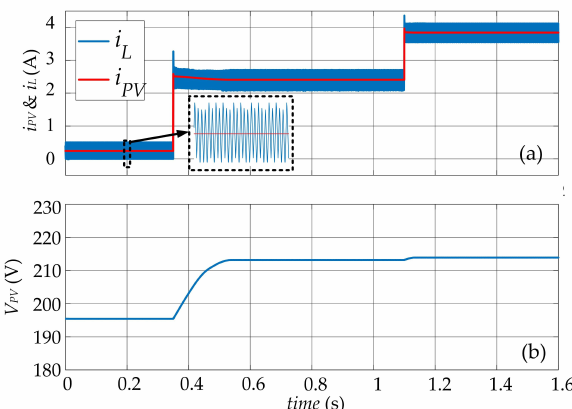
Figure 11. MPPT control of the PV array: ( a ) inductor current and ( b ) the PV array’s output voltage.